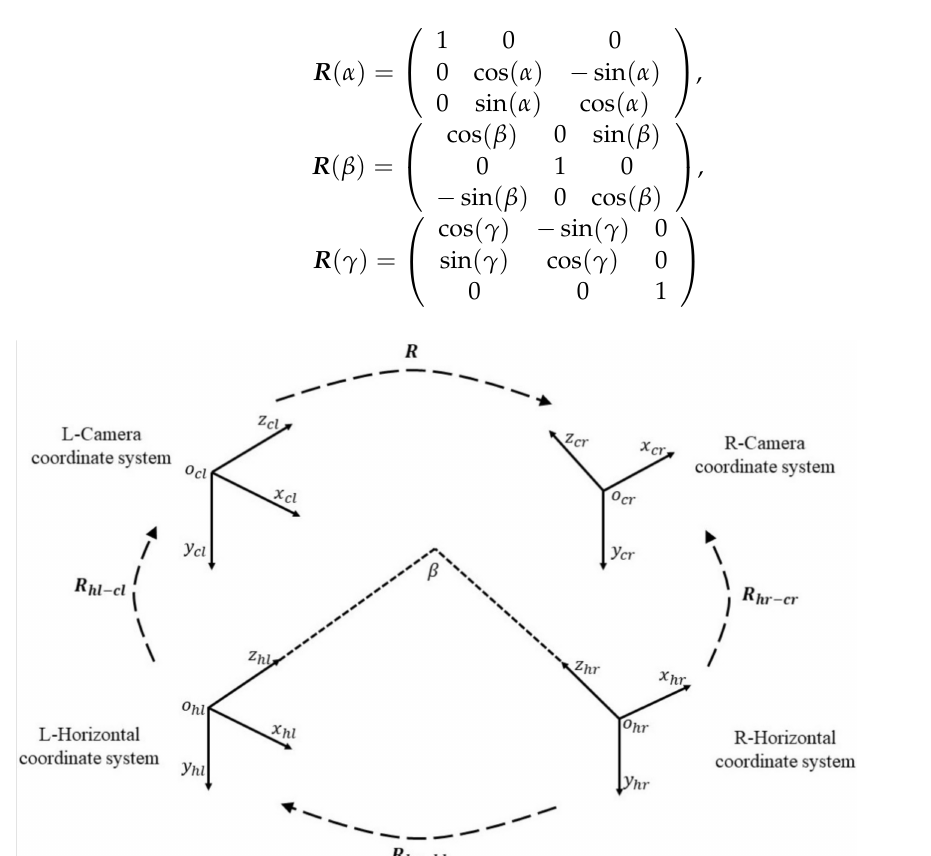
Figure 5. Conversion relationship between coordinate